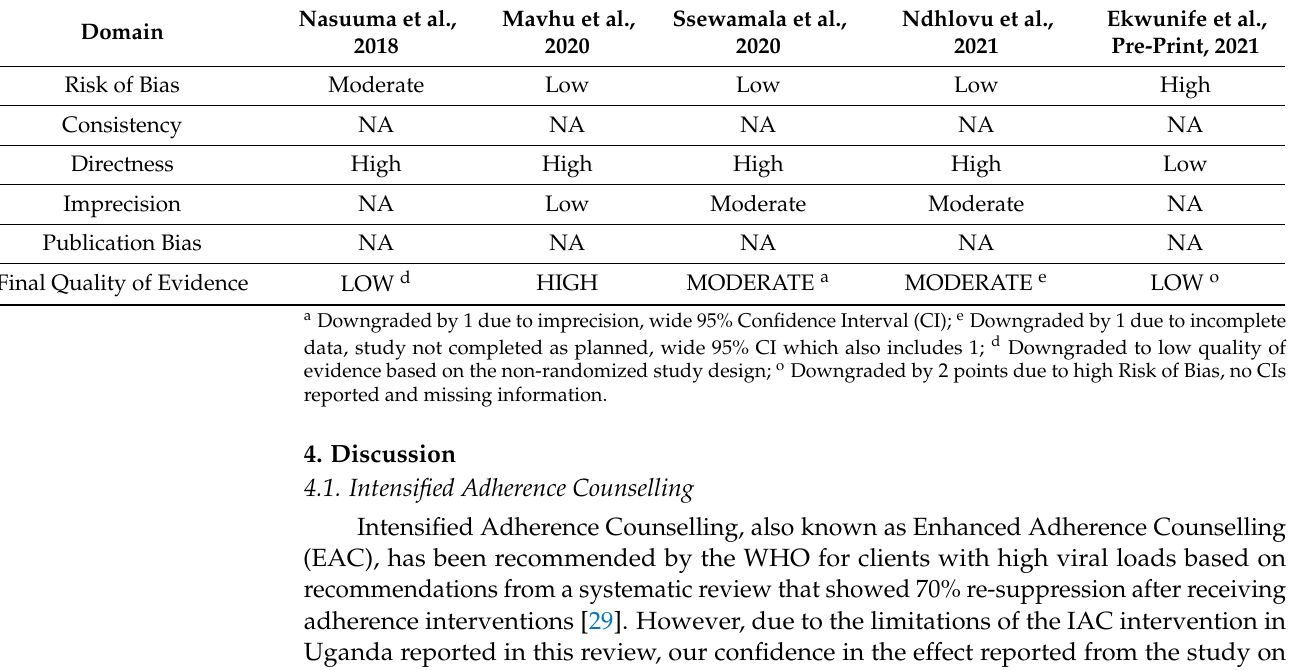
Table 4. GRADE (certainty of